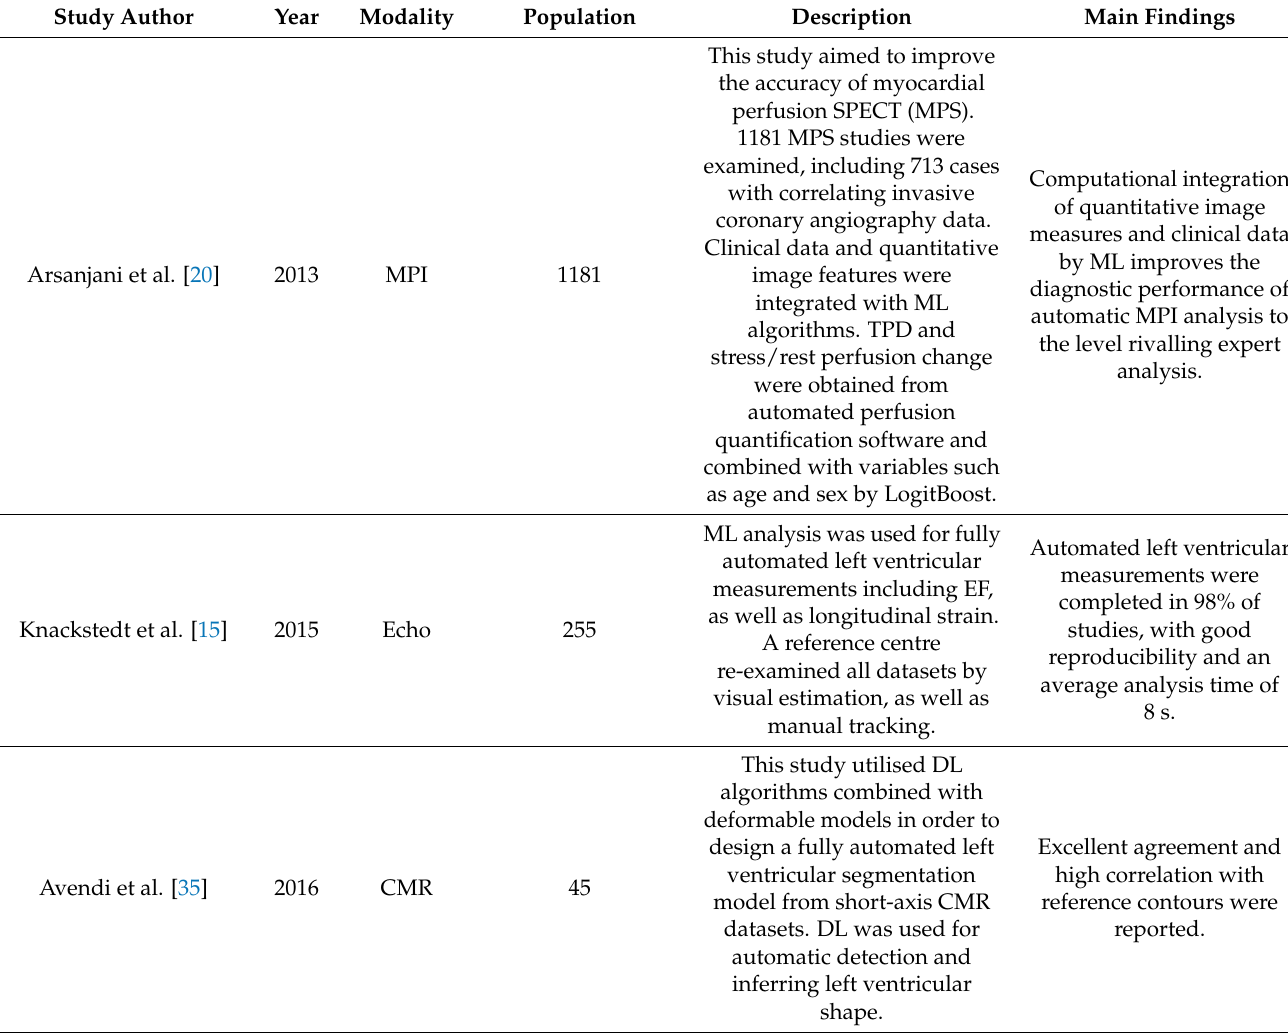
Table 1. Summary of some studies looking at the application of artificial intelligence and machine learning in non-invasive imaging for assessment of